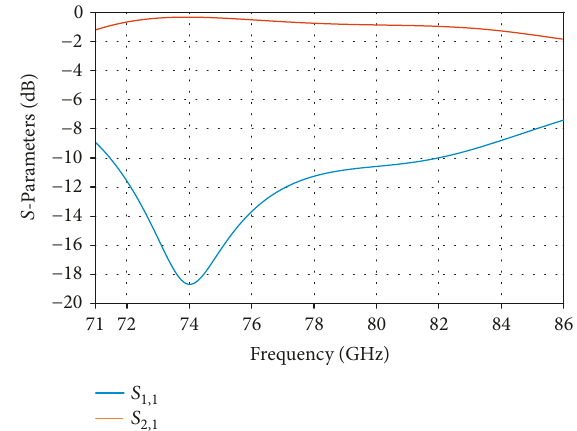
Figure 7: Simulated S -parameters of the ensemble consisting of the waveguide-to-PCB transition, phase shifter ( x =0 . 5mm), and the PCB-to-waveguide transition (see Figure